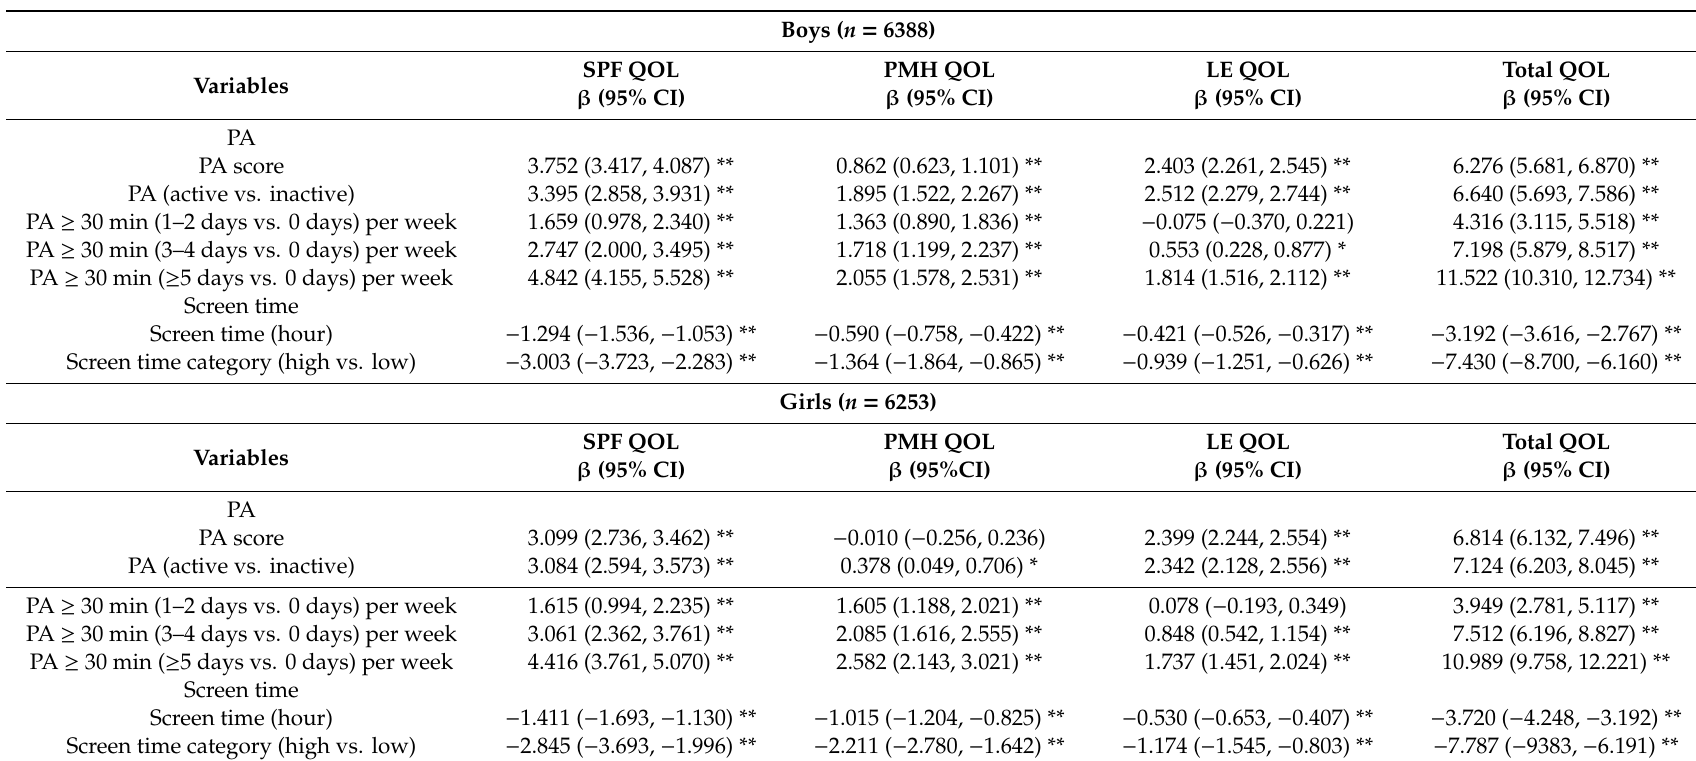
Table 4. Results from the multivariable general linear models evaluating the association of Physical activity and screen time with QOL in Boys and